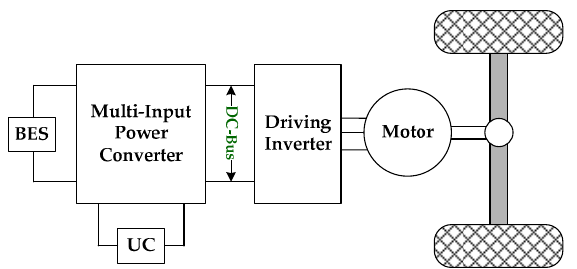
Figure 2. Multi-input power converter interfacing BES and UC to the DC-bus in the EV power train.